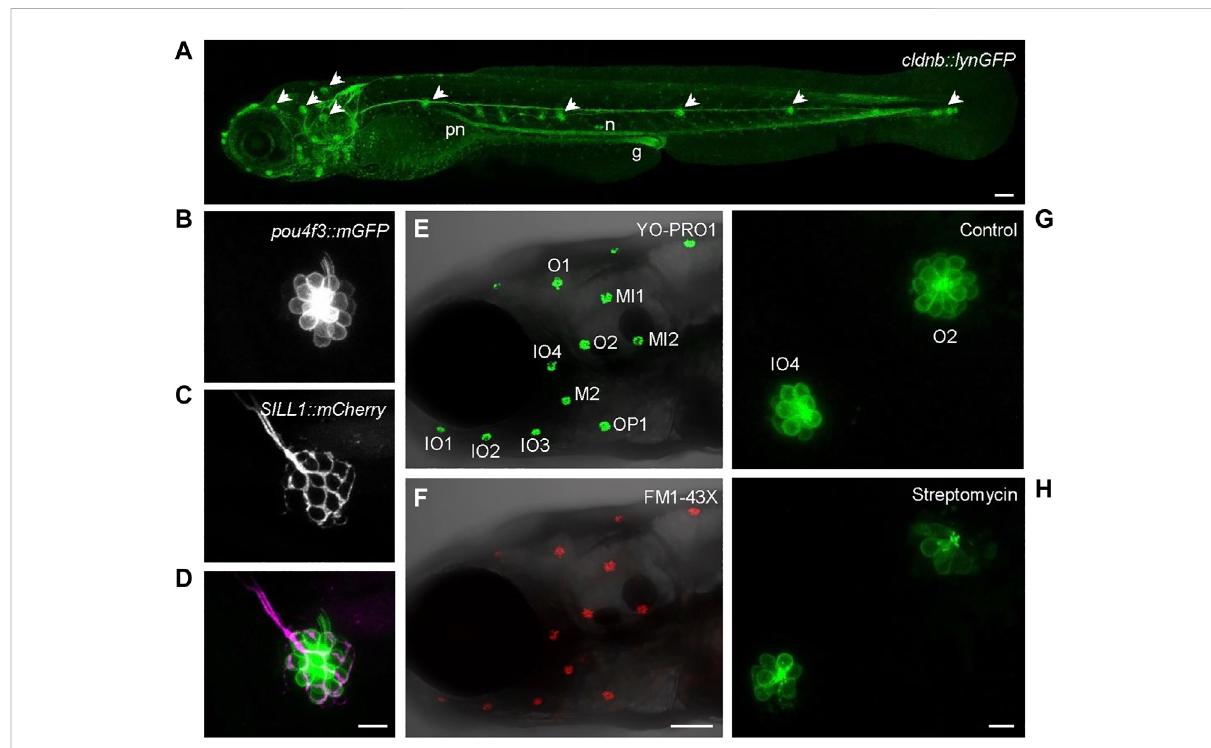
FIGURE 1 Images of hair cells in 5dpf zebra fi sh larvae. (A) Composite image obtained with laser scanning microscopy of a transgenic larva expressing cldnb::lynGFP (Haas and Gilmour, 2006), gift of Paola Bovolenta (CSIC, Madrid). Arrowheads point to some of the neuromast of the anterior (head) and posterior (trunk) lateral line. pn, pronephric duct; n, nephrons; g, distal gut. (B – D) Detail of an individual neuromast of the posterior lateral line showing (B) hair cellsexpressingthetransgene pou4f3::mGFP (Obholzer etal.,2008),giftofBertaAlisa(Univ.Pompeu Fabra,Barcelona); (C) its afferentinnervationexpressingthetransgene SILL1::mCherry (Pujol-Martíetal.,2012),giftofHernánLópez-Schier(HelmholtzZentrum,Munich); (D) overlay of the previous images. (E,F) Overview of the anterior lateral line showing hair cells labelled with (E) YO-PRO1 and (F) FM1-43X; neuromasts arelabelled according to (Raibleand Kruse, 2000).Inner ear haircells are notlabelledwith these dyes; otoliths are visible behindneuromasts O2 and MI2. (G,H) Image of two anterior lateral line neuromasts labelled with the transgene pou4f3::mGFP under standard conditions (G) or after treatment with theaminoglycosideantibiotic streptomycin (H) . Scale barinA, E, (F) 100 μ m; scale bar in (B,C,D,G,H) 10 μ m. All images taken intheMicroscopy Unit of Centres Cientí fi cs i Tecnològics de la Universitat de Barcelona (CCiTUB) at the Campus de